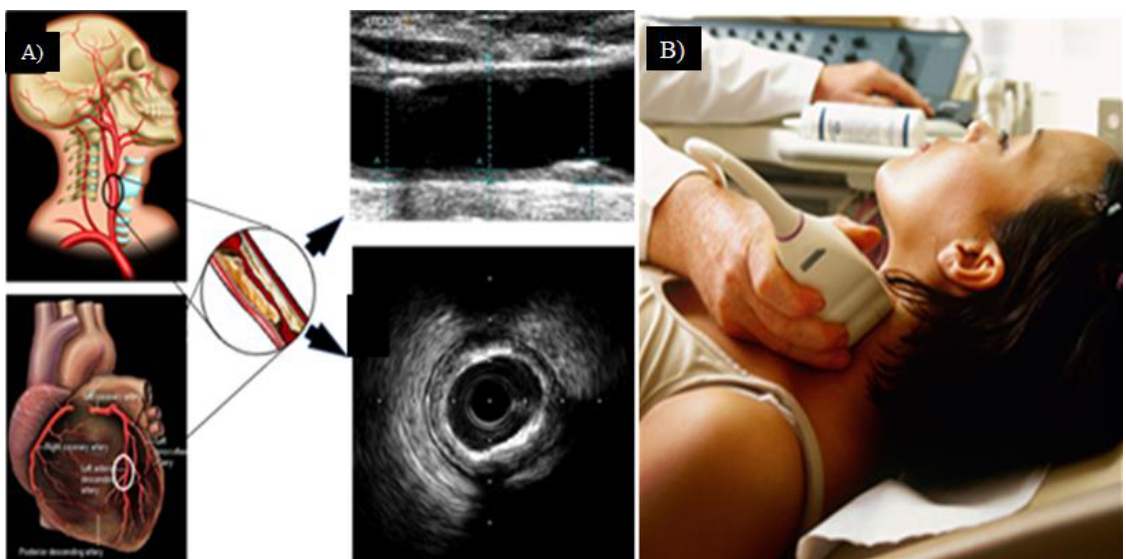
Figure 9. ( A ) CTAD is a potential surrogate marker for COAD, shown using an IVUS-based vascular cross-sectional scan. ( B ) B-mode carotid longitudinal imaging system using linear ultrasound [159].